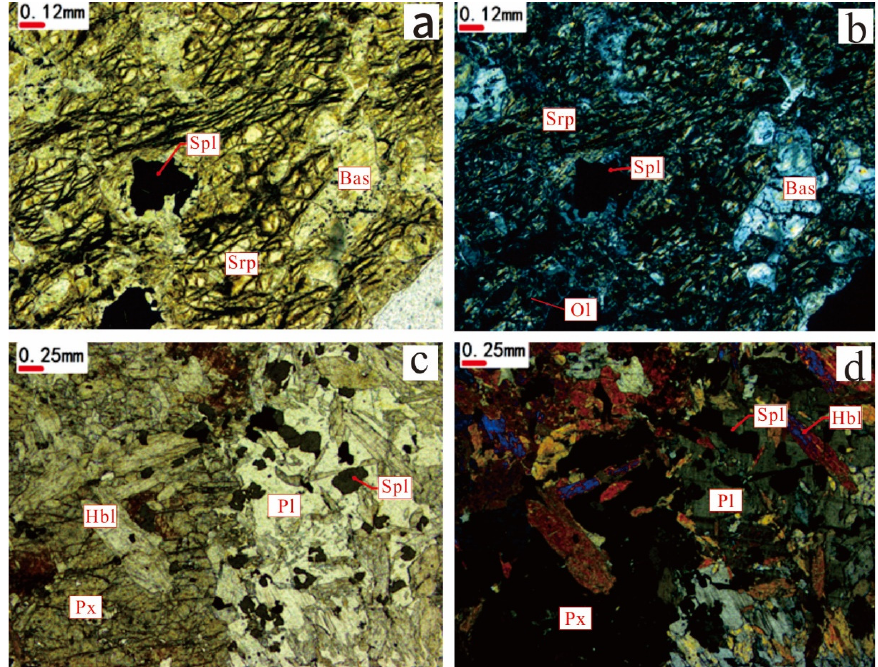
Figure 4. Single-polarized ( a , c ), cross-polarized ( b , d ). Light photomicrographs of ultrama fi c rocks in Santaishan ( a , b ) and Yingjiang ( c , d ). Px—pyroxene, Pl—plagioclase, Hbl—hornblende, Ol—oli- vine, Spl—spinel, Bas—Bastite, Srp—serpentine.